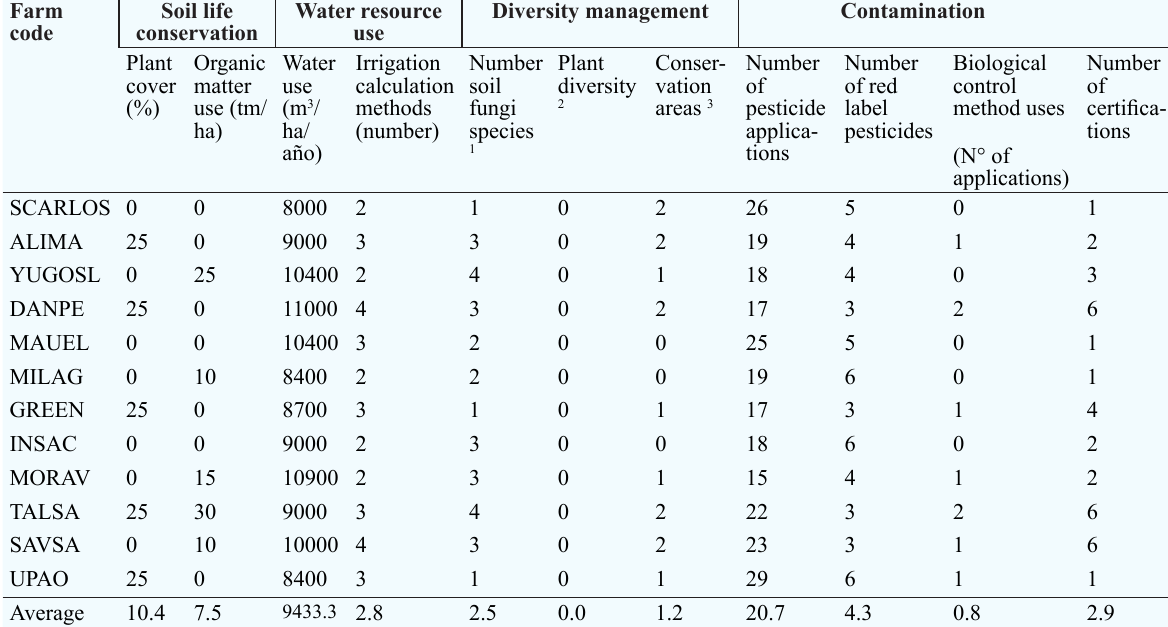
Table 2. Environmental indicators at asparagus farms of the Chavimochic irrigation project in December 2017. Farm code